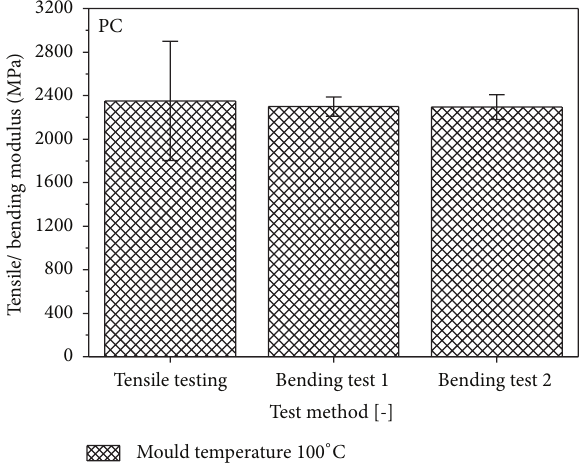
Figure 9: Tensile and bending modulus of the PC specimens. show the same or slightly higher modulus than the tensile test.